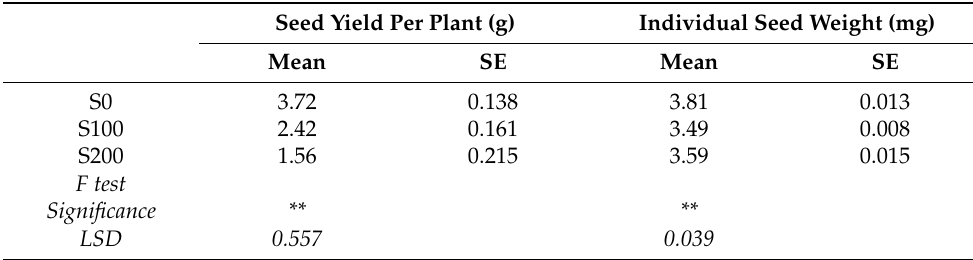
Table 1. Seed yield per plant and individual seed weight in the three salinity treatments S0, S100 and S200 (i.e., 0, 100 and 200 mM of NaCl in the solution used for watering the pots throughout the whole growing cycle of the mother plants). SE is the standard error.